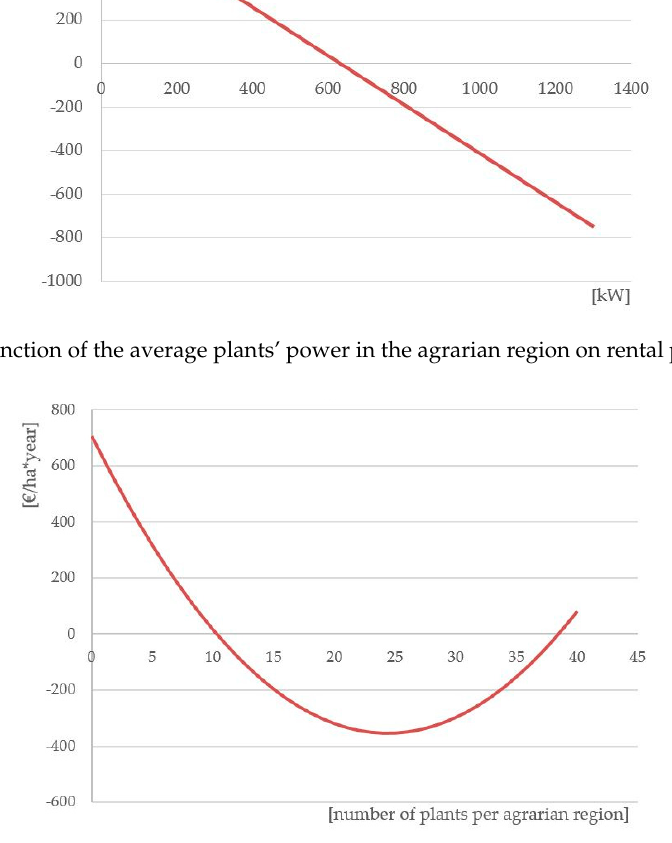
Figure 6. Function of the number of biogas plants in the agrarian region on rental price ( pl_r ).